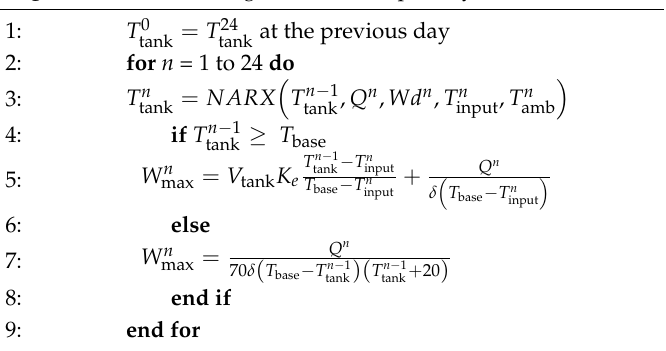
Algorithm 1 : Calculating Maximum Capability of EWH